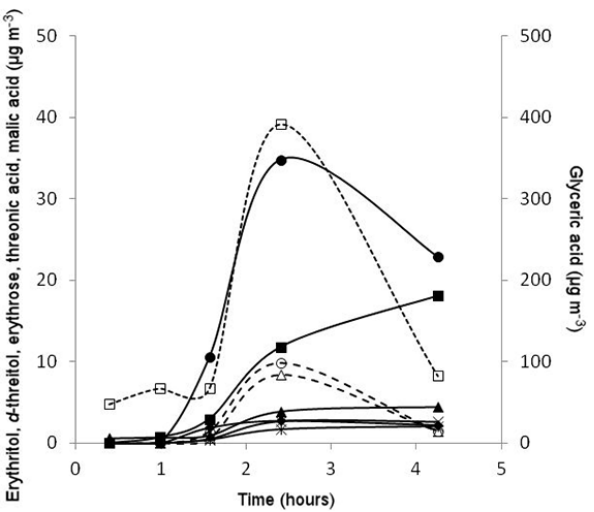
Figure 5. Time profile of gas- and particle-phase products from the oxidation of 13BD in experiment ER442. Quantitative analy- sis was done as BSTFA derivatives. d -threitol was used as a sur- rogate to quantify erythritol, threonic acid, and malic acid. Parti- cle phase/gas phase: ( (cid:4) )/( (cid:3) ) glyceric acid; ( • )/( ◦ ) threonic acid; ( (cid:78) )/( (cid:52) ) erythrose; ( (cid:7) )/( ♦ ) malic acid; ( ∗ /) threitol.